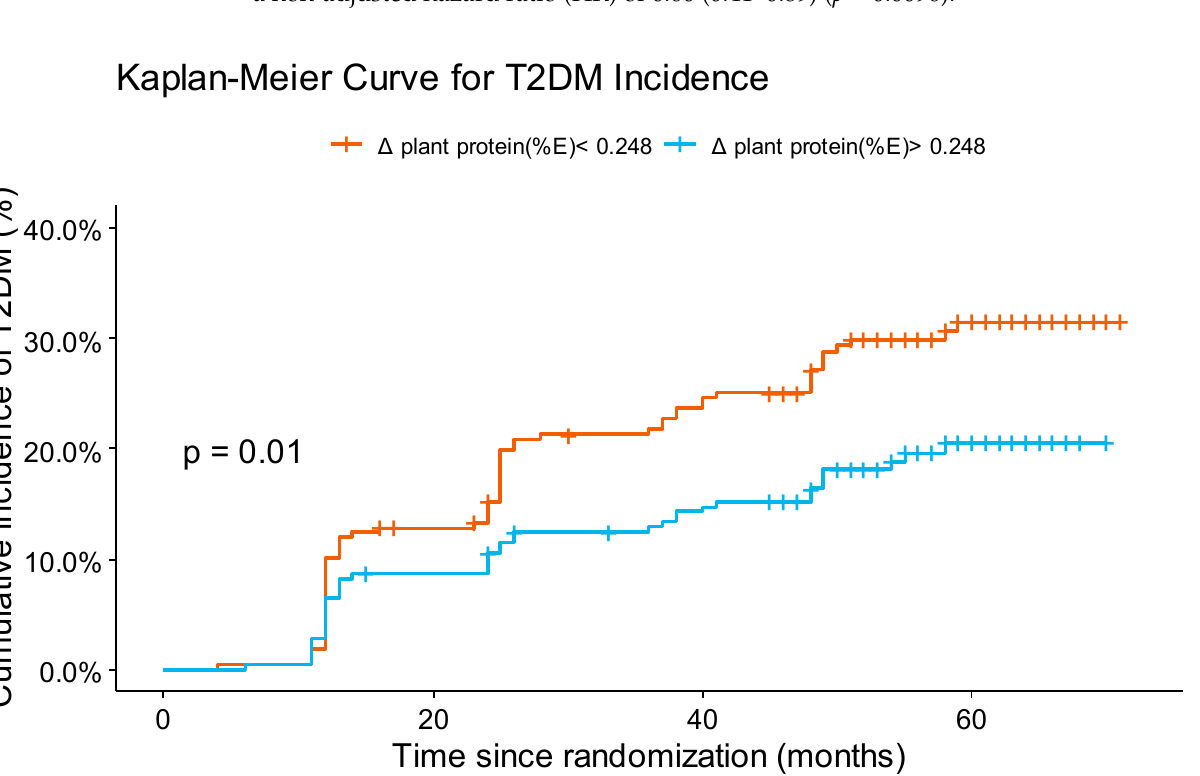
Figure 3. Cumulative incidence of type 2 diabetes mellitus (T2DM) (%). Cumulative incidence of T2DM (%) for two groups of patients: those with ∆ in plant protein (%E) intake (changes produced between post- and pre-intervention) below the median and those above the median. ∆ , change; T2DM: type 2 diabetes mellitus; E: energy.